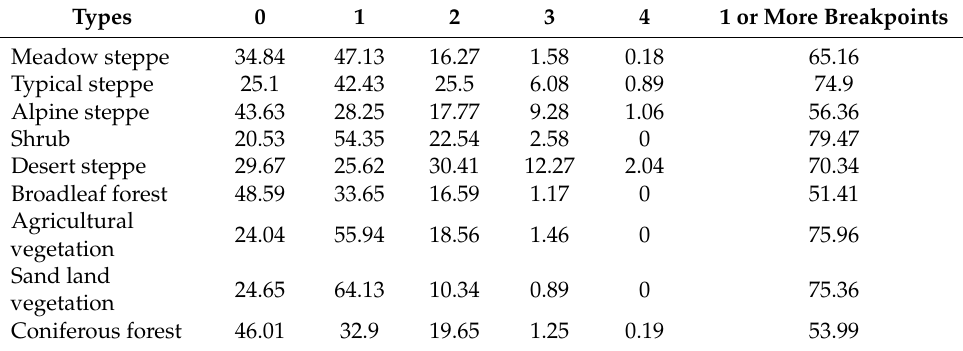
Table 3. Percentage of the specific land cover area for the different vegetation and steppe types, split by the number of breakpoints detected between 1982 and